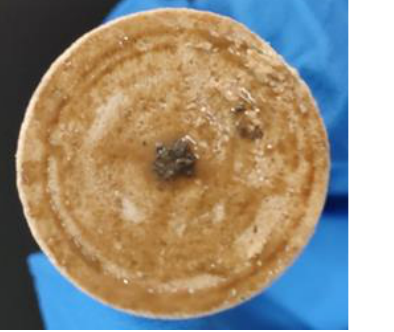
Figure 13. Core inlet ( left ) and outlet ( right ) after damage.